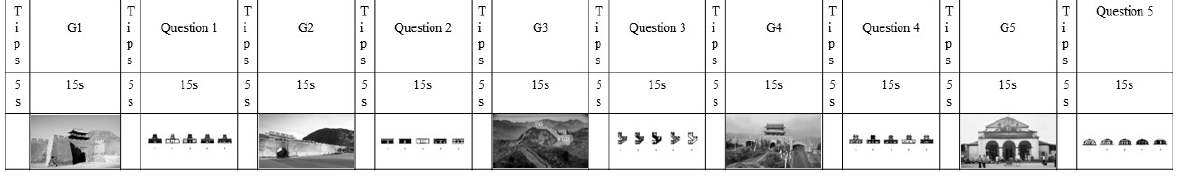
Figure 2. Experiment 1 process.